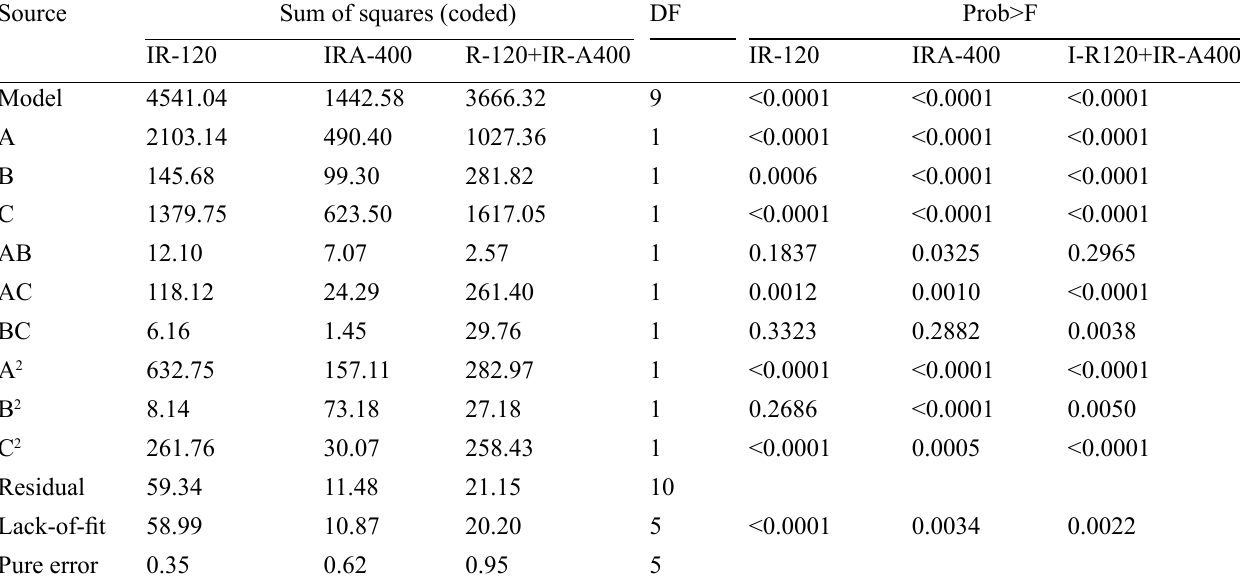
Table 4. Analysis of variance (ANOVA) for Th(IV) removal by ion exchange resins. Source Sum of squares